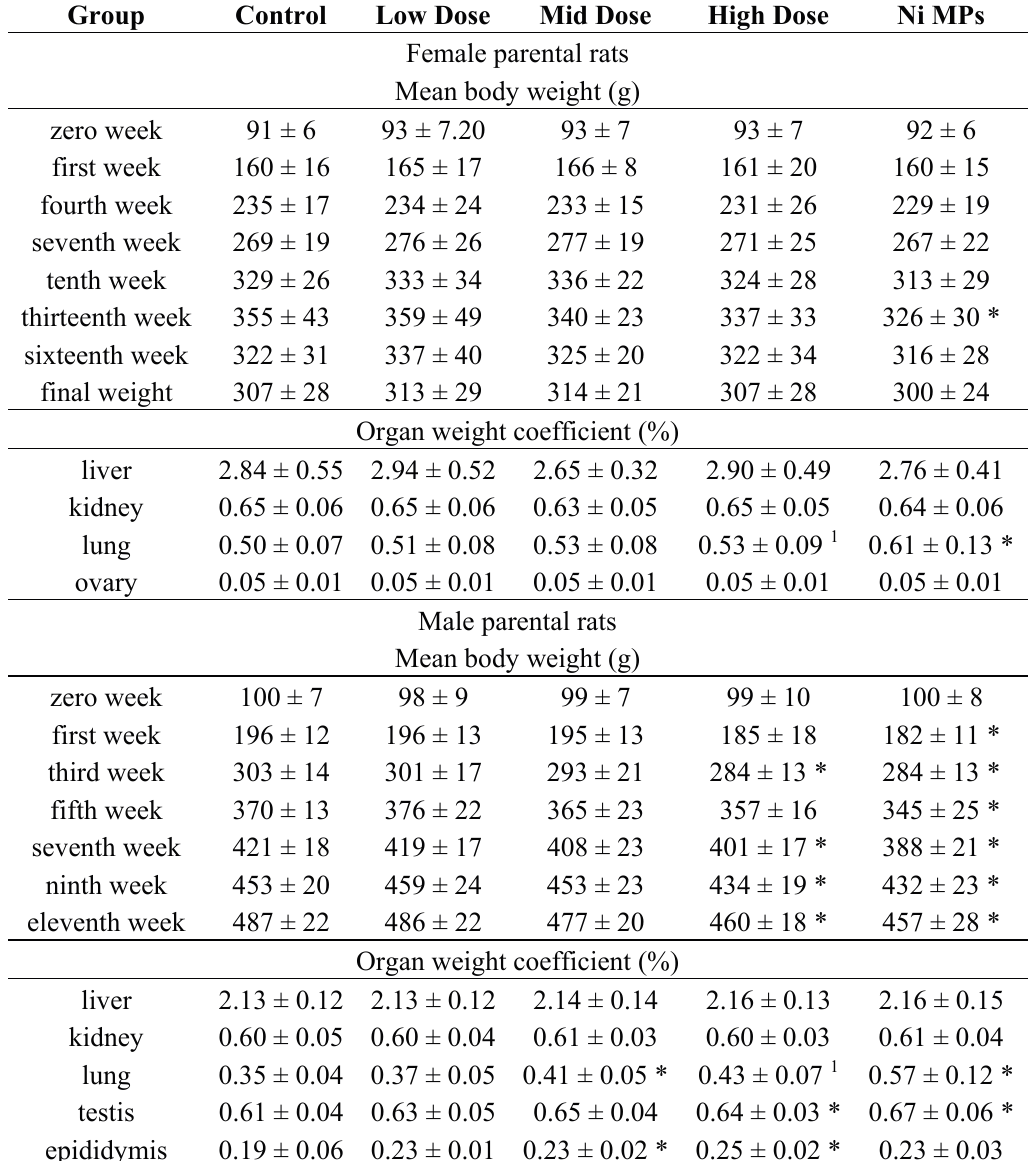
Table 1. Mean body weight and organ weight coefficients for female and male